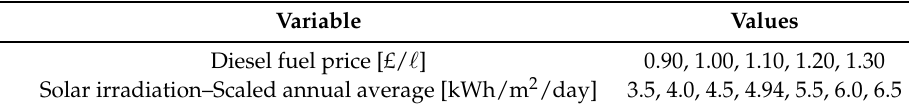
Table 6. Sensitivity analysis variables and corresponding values.